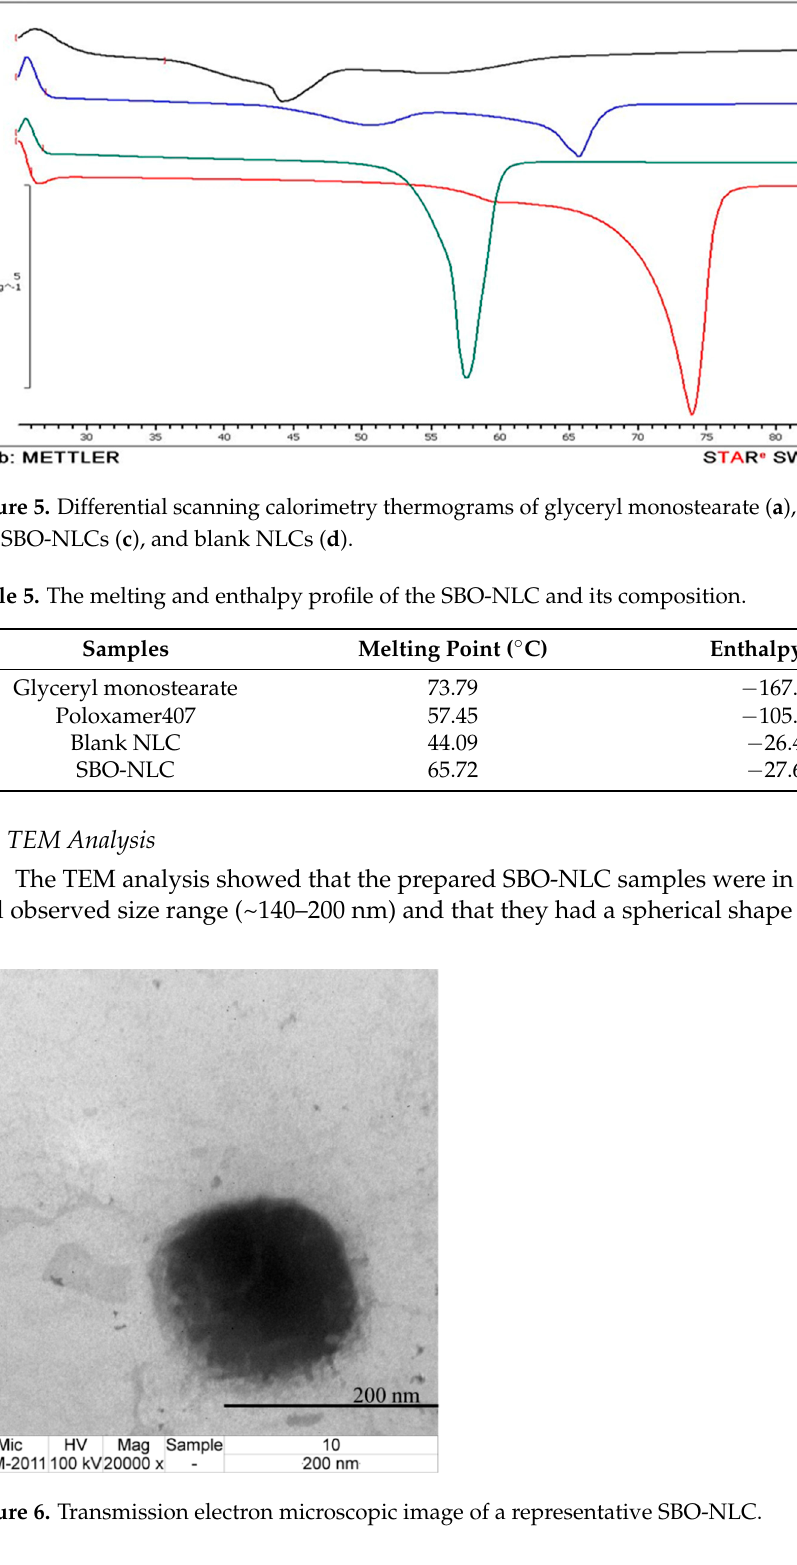
Figure 6. Transmission electron microscopic image of a representative SBO-NLC.